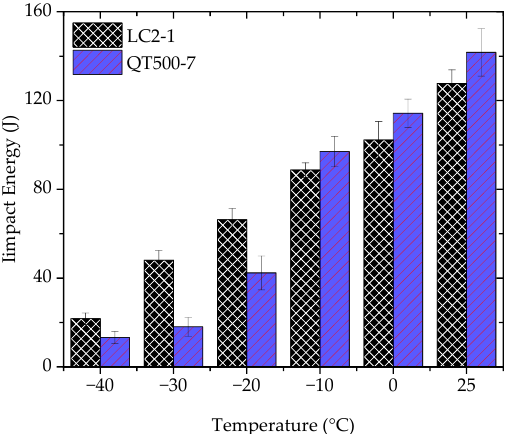
Figure 5. Variations of impact energy of the material with temperature.